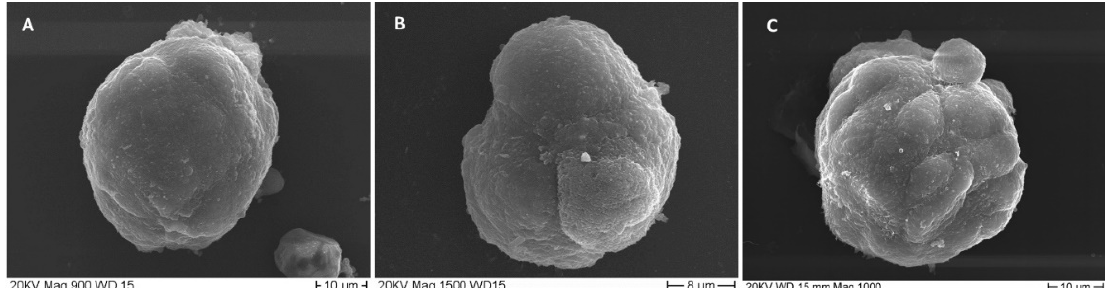
Figure 1. In vitro cultured MTSs were observed by scanning electron microscopy. ( A ) sample with a smooth outer surface is shown, magnification 900×, bar 10 µm. ( B ) Sample with superficial and shallow furrows is represented, magnification 1500×, bar 8 µm. ( C ) Spheroid with outer surface marked by deep and numerous grooves, cell borders are evident, and one cell stands out from the spheroid mass, magnification 1000×, bar 10 µm.